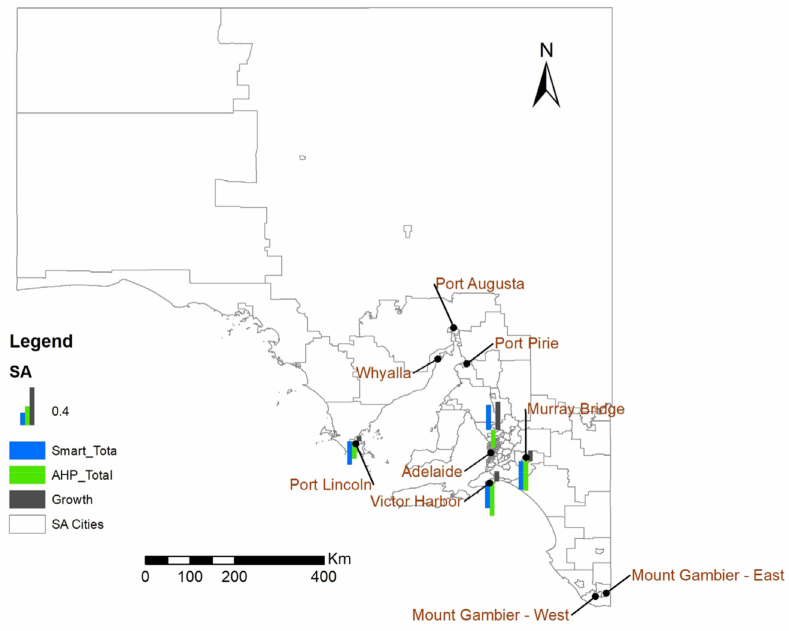
Figure 14. Smart and preferred city rankings of South Australian 9 cities and the population growth rates.